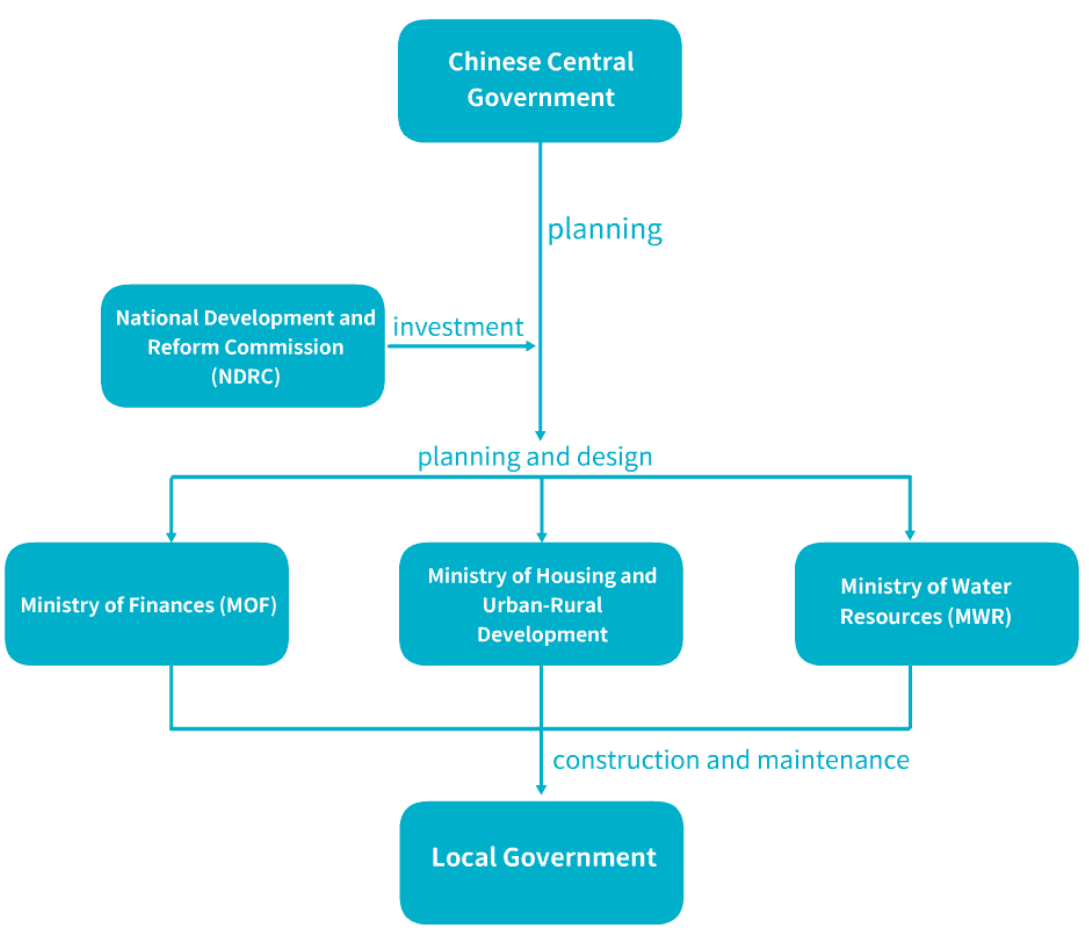
Figure 3. The roles of governmental institutions in SCP practice. Source: authors.